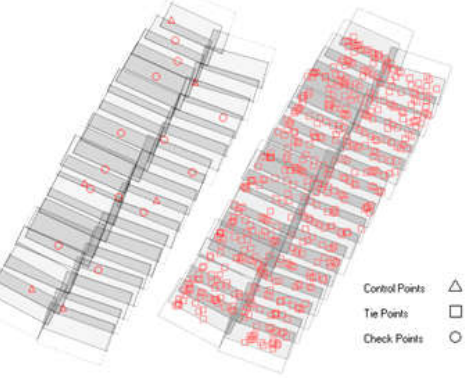
Figure 5. Block configuration used in the